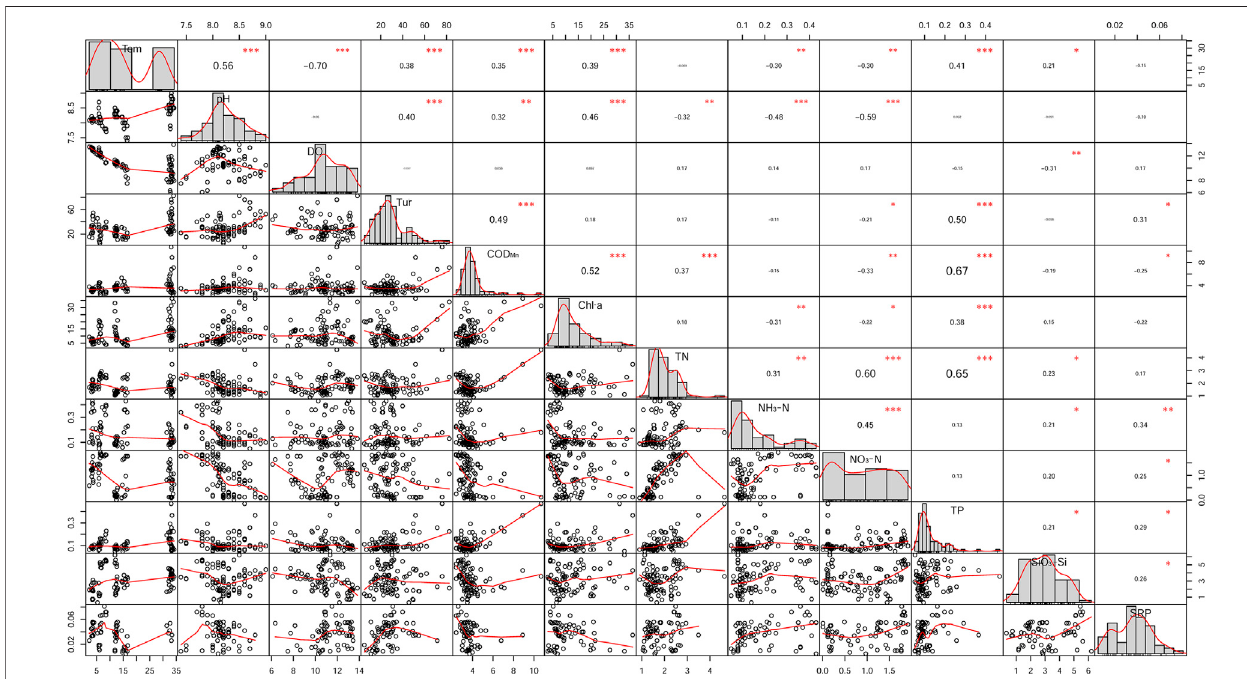
FIGURE4| Thecollinearityanalysisofthe12monitoredphysicochemicalparametersonallsixsamplingdays.[DO,dissolvedoxygen;SiO 3 -Si,activesilicate;NO 3 - N, nitrate; NH 3 -N, ammonia; TN, total nitrogen; TP, total phosphorus; Temp, water temperature; Chl a, chlorophyll a; COD Mn , permanganate index; the single asterisk representssigni fi cantcorrelations (Pearson correlation, p ≤ 0.05); thedoubleasterisk means highly signi fi cantcorrelations( p ≤ 0.01);the triple asteriskmeansextremely signi fi cant correlations ( p ≤ 0.001)].